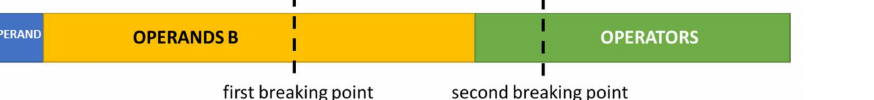
Figure 7. Breaking points (sometimes called crossover points) in the structure of individuals from